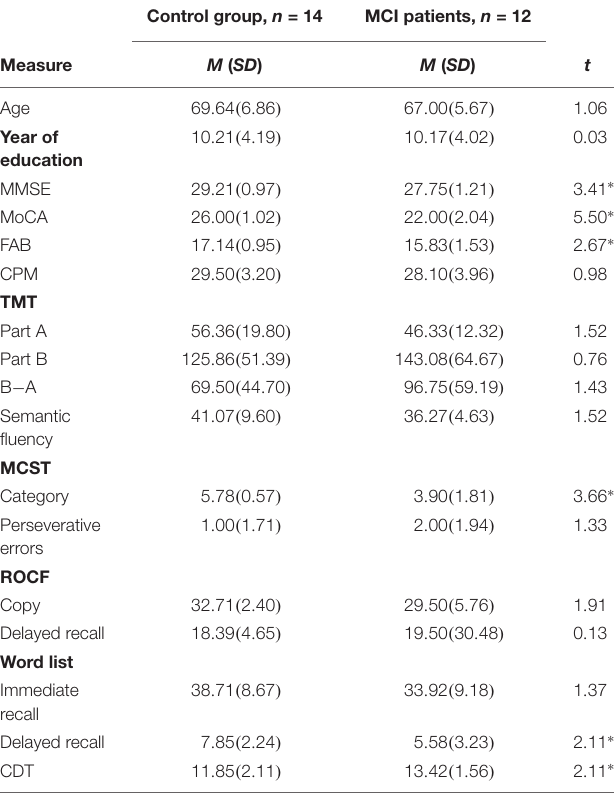
TABLE 1 | Mean and standard deviation for descriptive statistics and neuropsychological evaluation for control and MCI